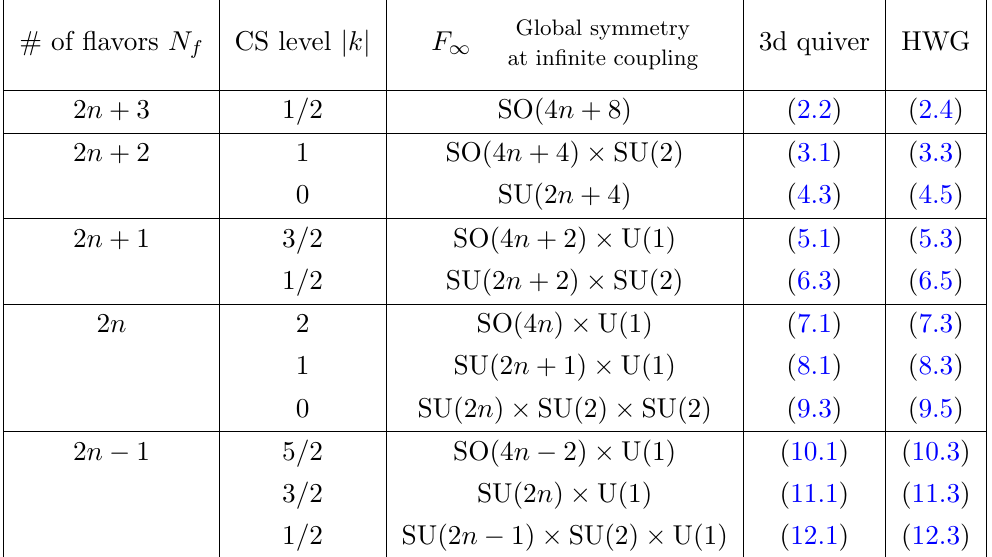
Table 1 . A summary of all (cid:13)avor symmetry enhancements of the cases studied in this paper. The two main results of the paper are referenced by equation numbers: the 3d quiver and the highest weight generating